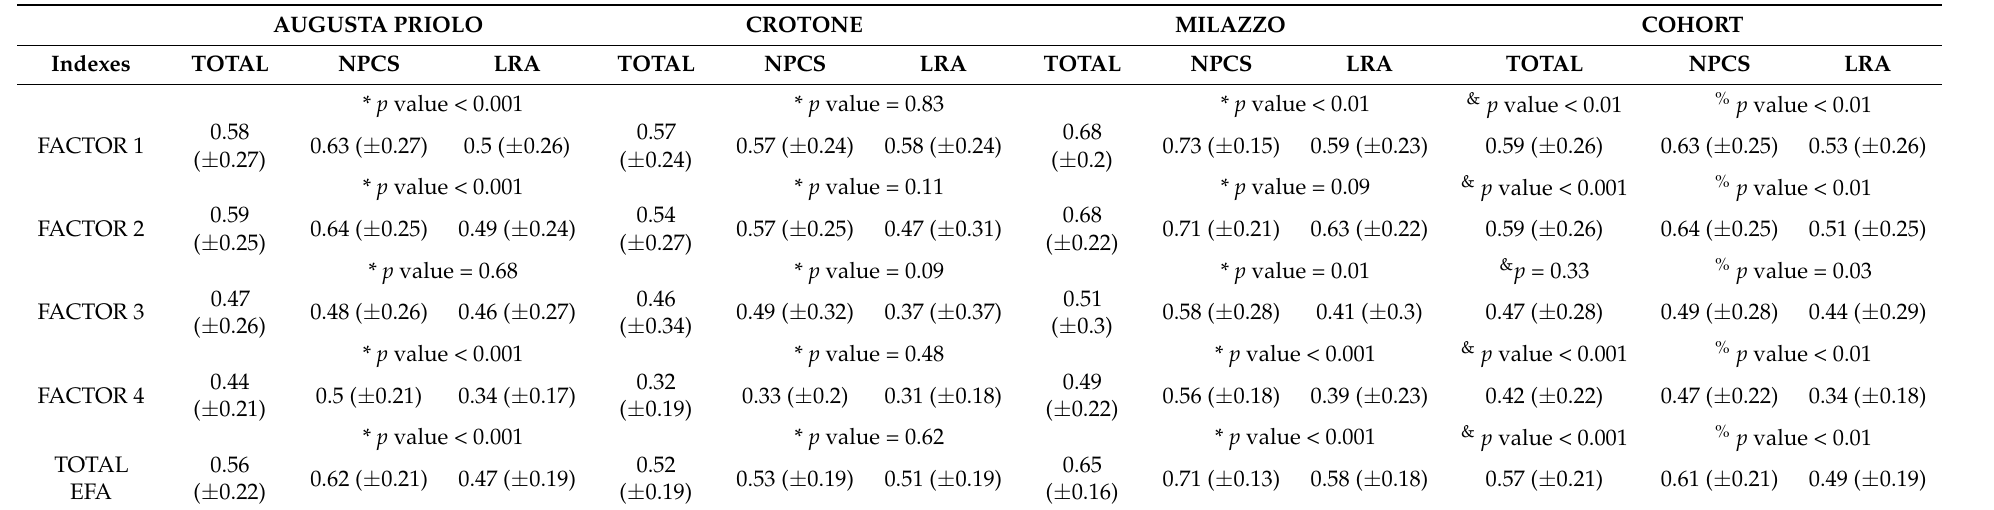
Table 4. Risk perception indices from the exploratory factor analysis